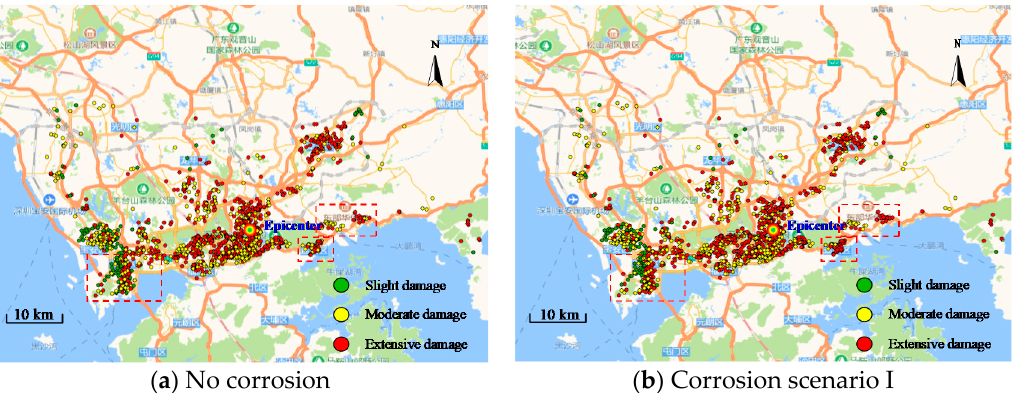
Figure 16. Distributions of building seismic damage results (M7.5). ( a ) No corrosion; ( b ) Corrosion scenario I